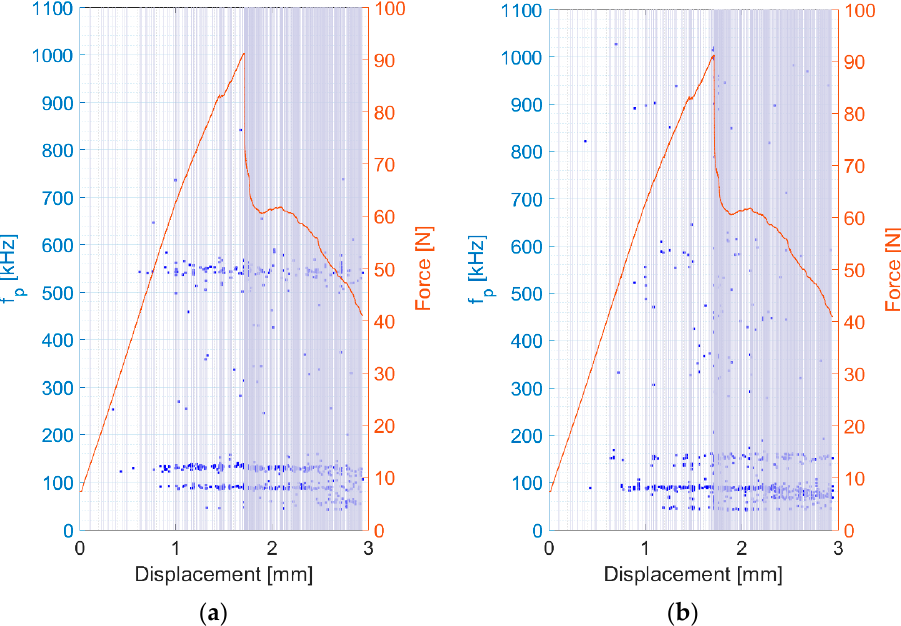
Figure 5. Peak frequency and force versus displacement results of the fibre bundle tensile test. ( a ) DWC 454 AE sensor; ( b ) Fujicera 1045S sensor.